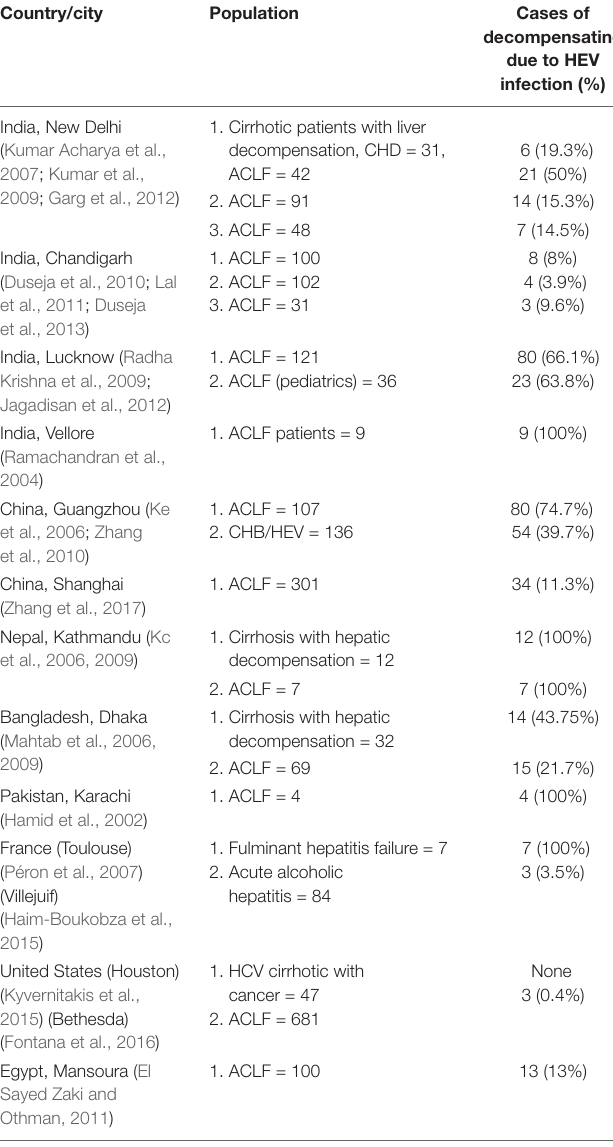
TABLE 1 | Presenting the cases/studies around the world, i.e., India, China, Nepal, Pakistan, United States, France, and Egypt, etc., where HEV manifests as an acute-on-chronic liver failure (ACLF) and/or chronic liver disease